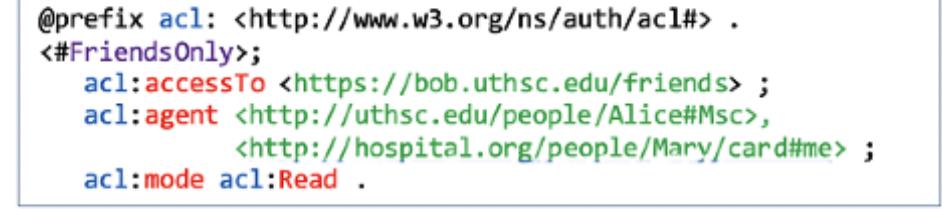
Figure 9. An ACL rule granting Read permission to Alice and Mary on Bob’s “Friends” document.